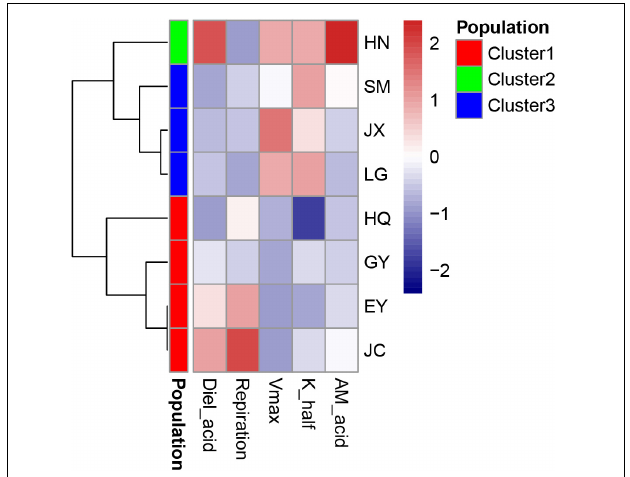
FIGURE 3 | The cluster analysis of carbon-related leaf traits in the eight Ottelia populations. AM_acid is the acidity of the leaves at ca. 7 am (unit: µ equiv g − 1 FW). Diel_acid is the changes of leaf acidity between ca. 7 am (dusk) and 7 pm (dawn) (unit: µ equiv g − 1 FW). V max is the maximum rate of net